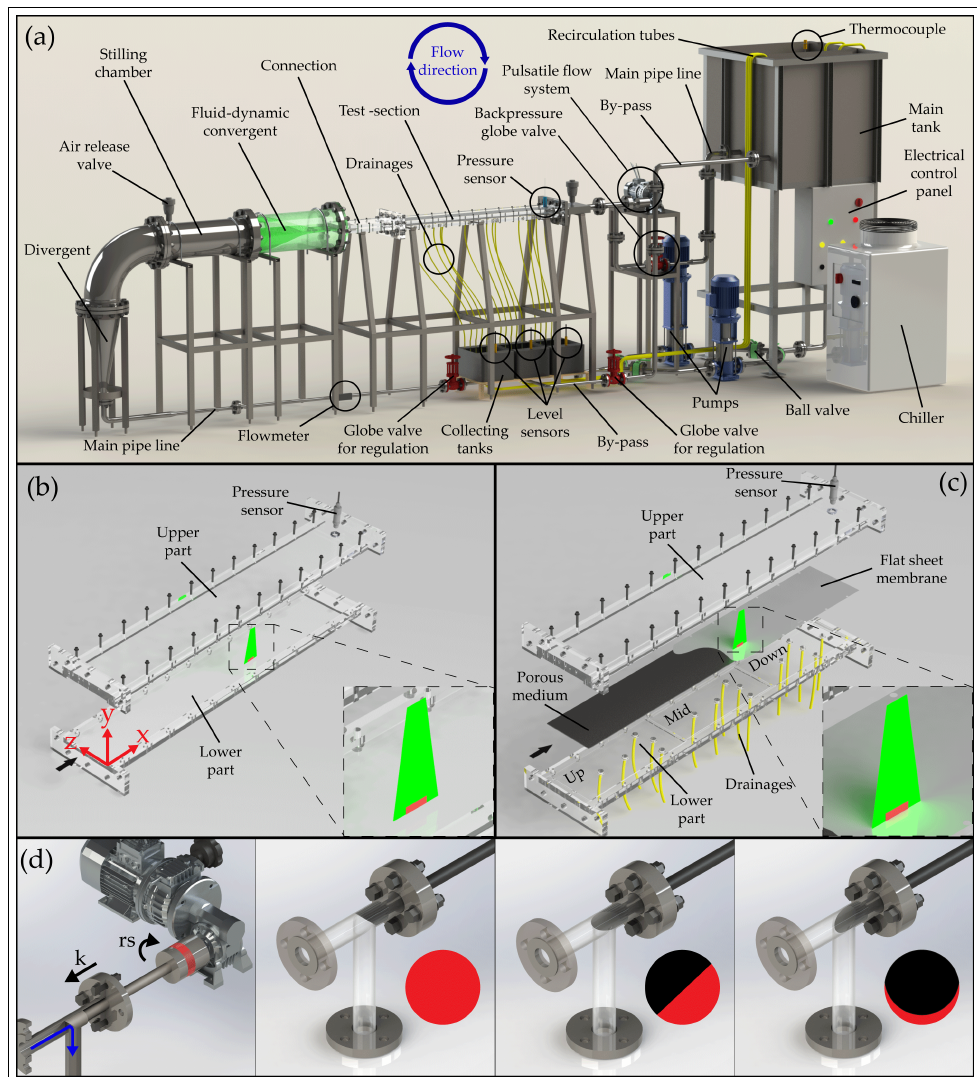
Figure 1. Overview of the proposed setup: ( a ) Rendering of the entire hydraulic facility. ( b ) Sketch of test section used for the fluid-dynamic validation of the system. ( c ) Sketch of the test section used for membrane tests. ( d ) Representation of the system used to generate the pulsating flow, where rs is the rotation speed and k is the distance of the rod in respect to the elbow. The outflow area (red) varies during each cycle as a function of the angle of the truncated rod (in this setup set at 45 ◦ ). Panel ( b ) also shows the reference system used in the present study; the origin is chosen at the right-bottom entrance of the test section and x, y, z coordinates correspond to streamwise, wall-normal and spanwise directions,